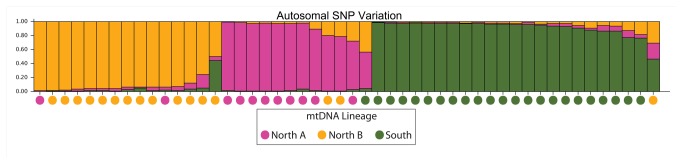
Inferred Population Structure.Inferred population structure based on autosomal SNPs using Structure (burnin period 100,000 cycles; 500,000 MCMC reps) with K=3, sorted by Q. The coloured circles below each bar represent the mitochondrial haplotype. The colour was chosen based on the bar plot colours where the majority of the mitochondrial lineage (North A, North B, South) is found.